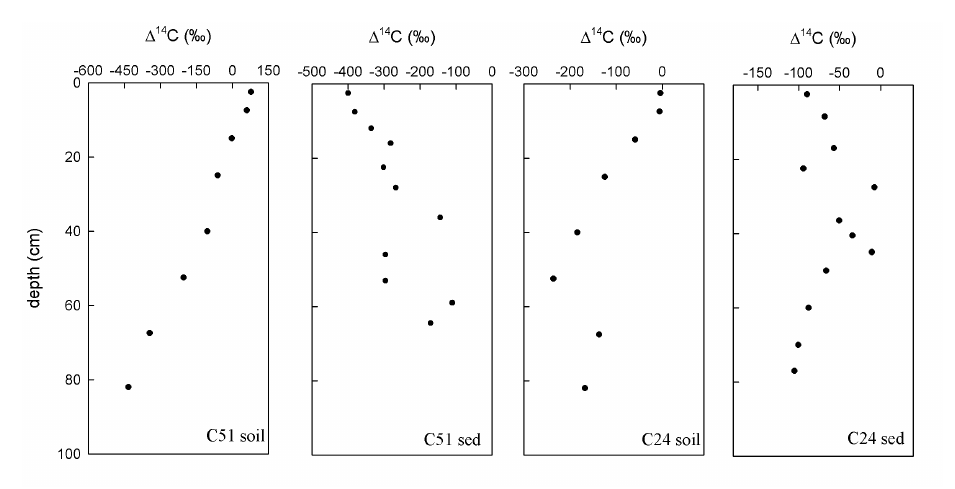
Fig. 4. 1 14 C (‰) values at the different depths in the soil (soil) and sediment profiles